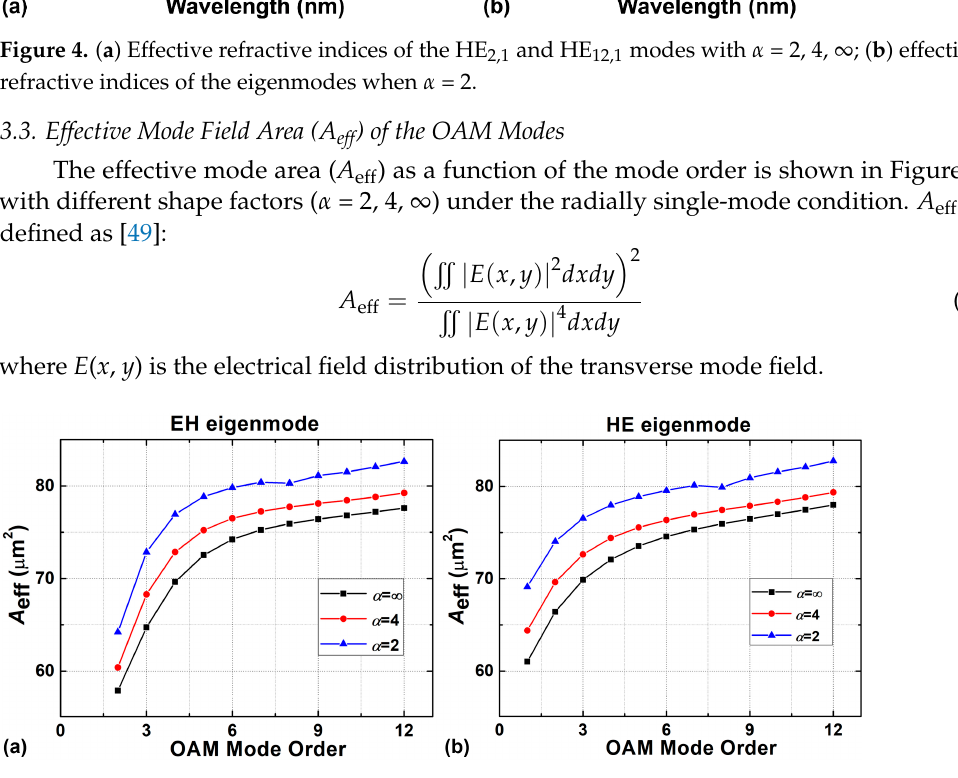
Figure 5. Effective areas of ( a ) the EH-composed OAM modes and ( b ) the HE-composed OAM modes in the ring-core fiber with α = 2, 4, ∞ .